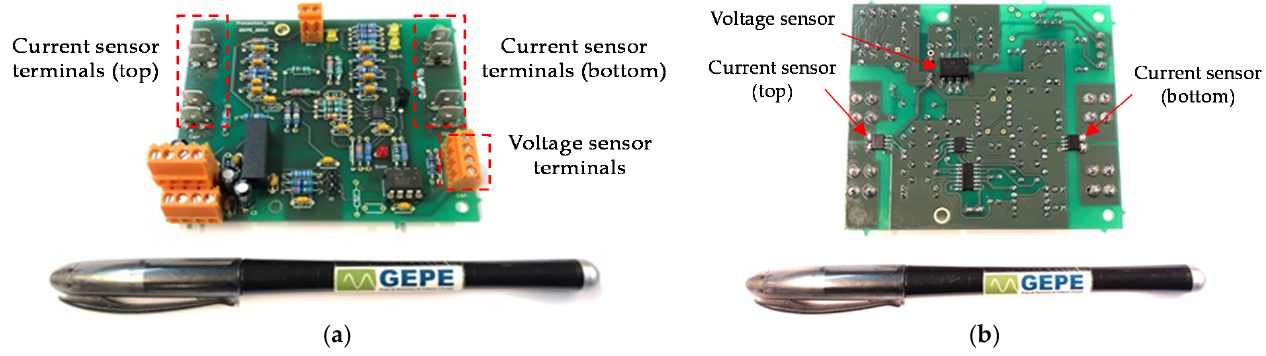
Figure 9. Protection circuit board: ( a ) top view; ( b ) bottom view.